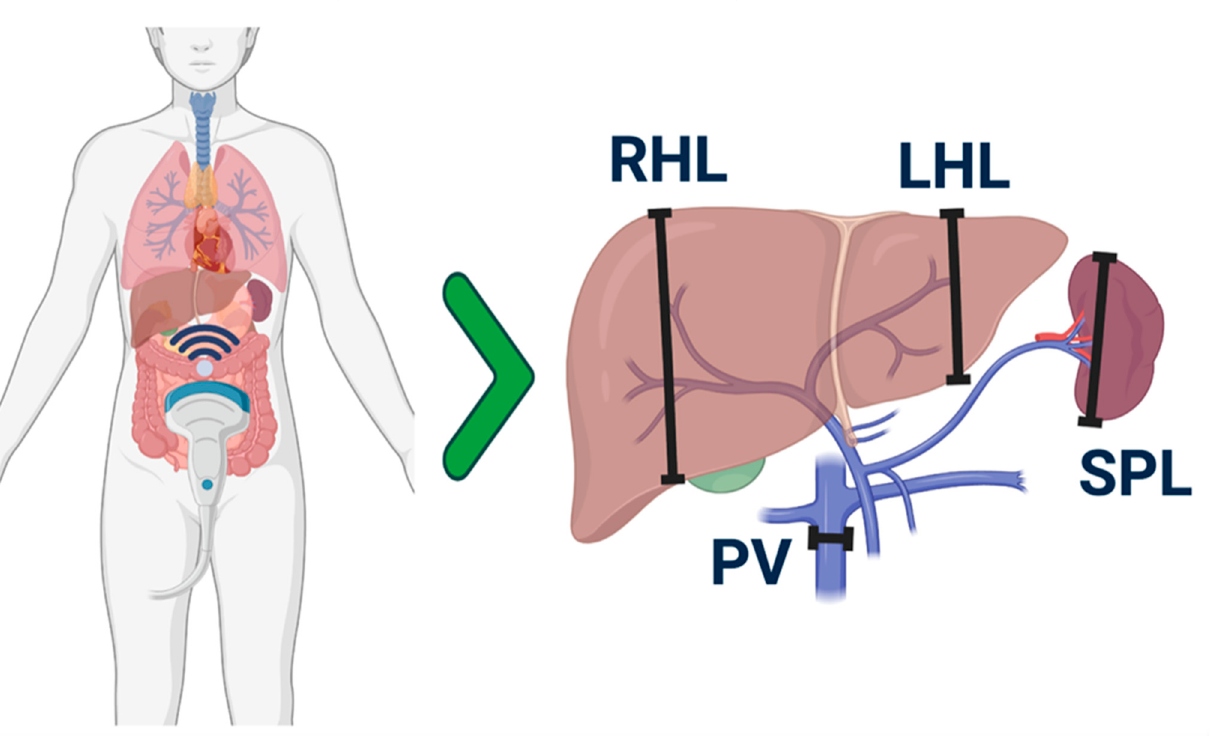
Table 1. List of the Parameters required by HokUS-10 US score system to diagnose SOS/VOD and additional parameters analyzed.